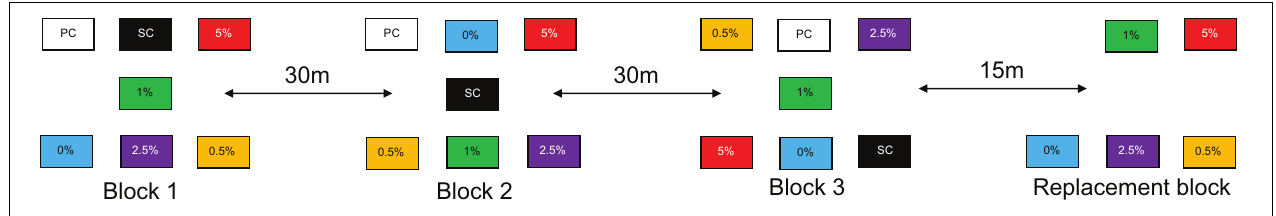
FIGURE 2 | The layout of the three sampling blocks and the replacement block at the experimental site. The blocks were set up parallel to the shore to prevent tidal elevation effects. The replacement block did not include a PC or SC treatment.